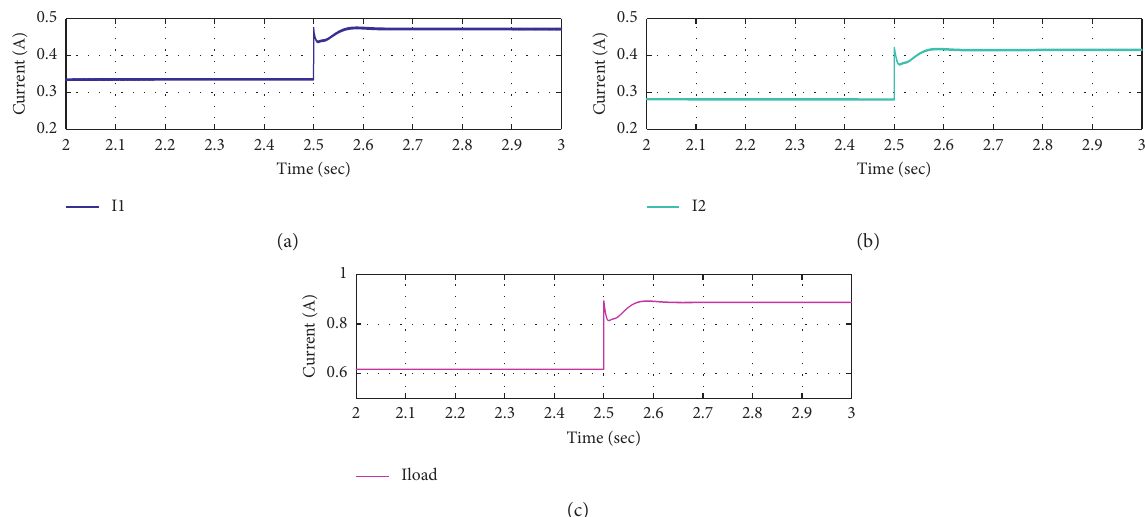
Figure 8: Simulation results for an increase in the load. (a) Output current of converter I. (b) Output current of converter II. (c) Total load